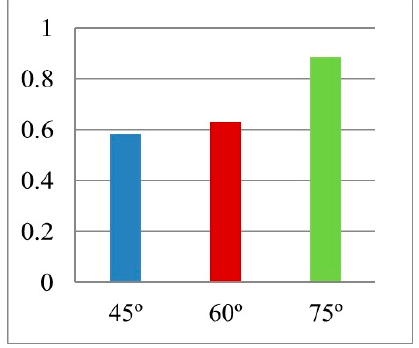
Figure 16. Max. value of RFd/P for 3 different cell angles.